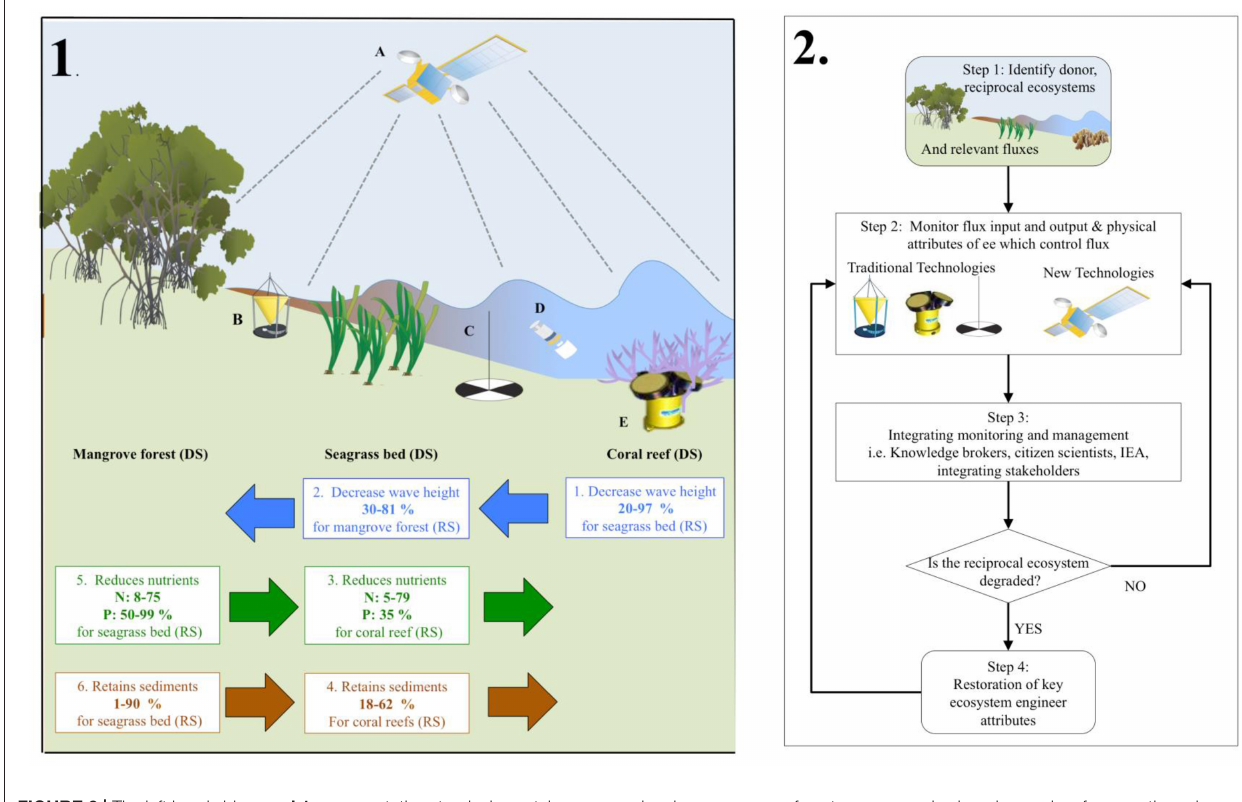
FIGURE 2 | The left hand side panel 1 , representatives tropical coastal seascape showing a mangrove forest, a seagrass bed, and a coral reef; energetic and material exchanges among them; and illustrative monitoring technologies (A–E). All three ecosystem types can be both donor ecosystems (DS) and recipient ecosystems (RS) with respect to energetic and material exchange (see text). Ecosystem engineering within each ecosystem type modifies exchanges among ecosystems of hydrodynamic energy (blue arrows and numbered text boxes), nutrients (green arrows and numbered text boxes—N: Nitrogen. P: Phosphorus), and sediments (brown arrows and numbered text boxes). Arrows indicate the direction of exchanges from donor to recipient ecosystems. Numbered boxes show the connection between the donor and most proximate recipient type of ecosystem; the kind of donor ecosystem effect on a recipient ecosystem; and the known range of this effect magnitude. A variety of monitoring techniques, often complementary, can be used to: Determine if ecosystem proximity is sufficient for connectivity; measure energetic and material exchanges among donor and recipient ecosystems; ascertain the physical structures of donor ecosystems responsible for the extended ecosystem engineering effects and measure the responses of recipient ecosystems (see text for details). Illustrated here are: A. Satellite detecting changes in cover; B. Sediment trap; C. Secchi disk measuring water transparency; D. Water quality sampling; E. Acoustic Doppler Current Profiler (ADCP) measuring water flux. The right hand side panel 2 , showing a flow chart of the steps and tools that can be utilizing to integrate connectivity into tropical management. The beginning of the flow chart (step 1) shows connected unites of mangrove forest, seagrass bed, and coral reefs from left to right. Where ecosystem-engineering reduction of fluxes is indicated. The physical structure of the ecosystem system engineers and flux dynamics can be monitored either traditional monitoring or new technologies (step 2). The data from monitoring can be integrated for management utilizing established tools (step 3), which in turn can be used for both intervention in the tropical